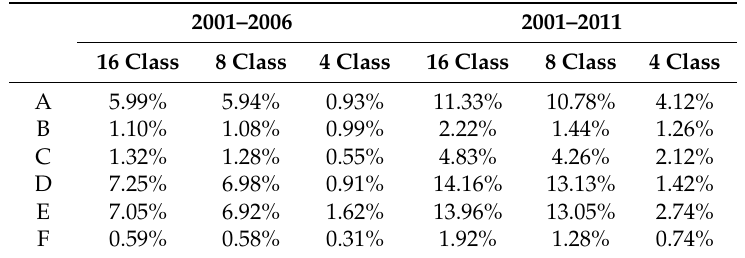
Table 2. Land cover changed area percentages for different areas during 2001–2006 and